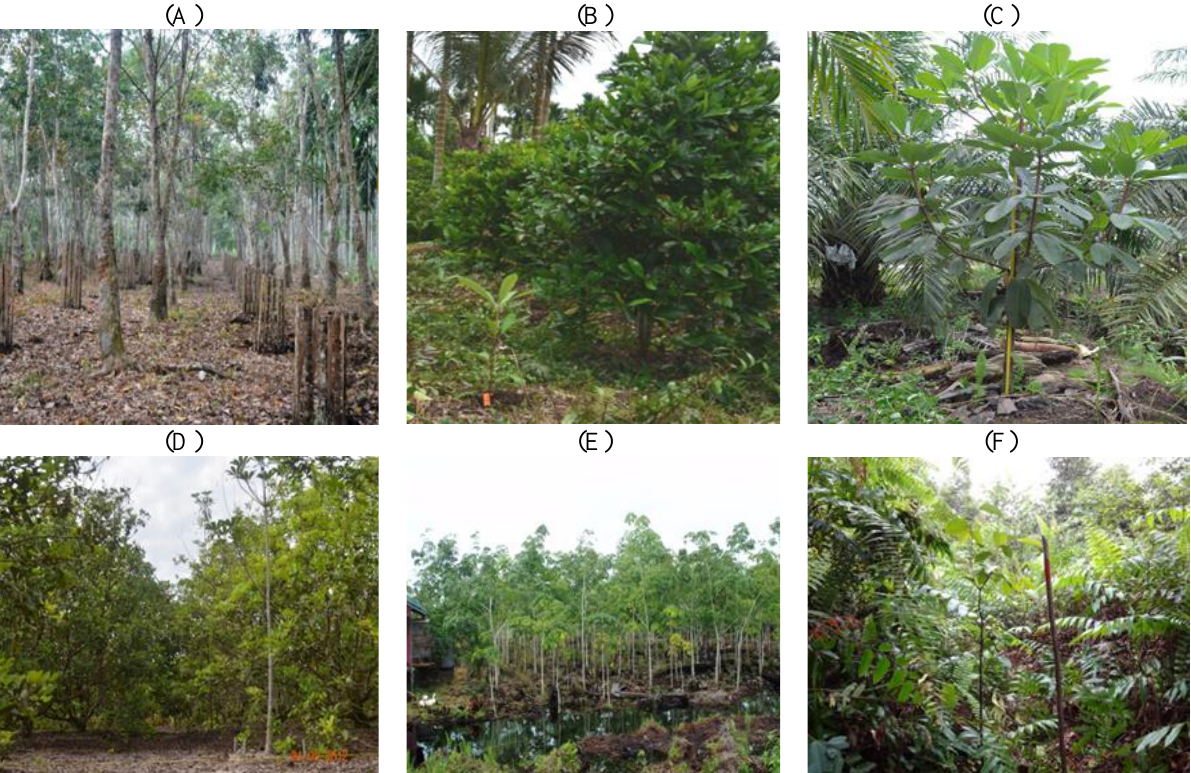
Figure 2. Farming systems on peatlands in Tanjabar (A–C) and Tumbang Nusa (D–F). (A) Mixed rubber+jelutung. (B) Mixed coffee+jelutung+betel nut. (C) Mixed oil palm+jelutung. (D) Mixed jelutung+rambutan. (E) Mixed rubber+jelutung+ Shorea balangeran . (F) Enrichment planting of Shorea balangeran +jelutung on shrub